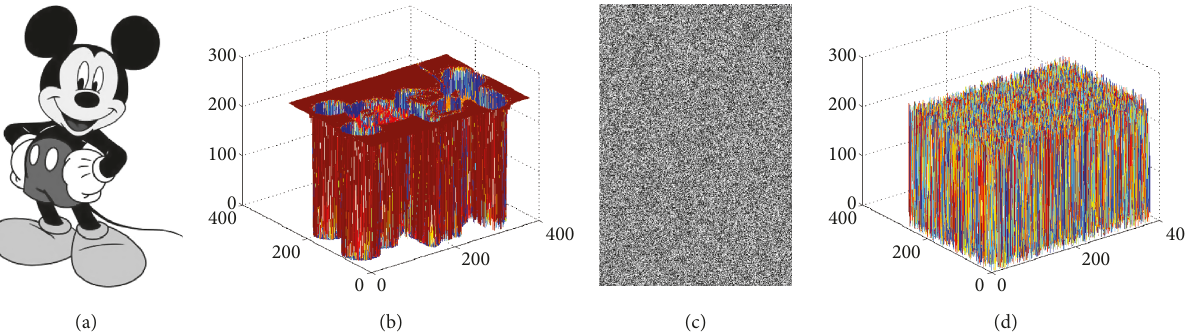
Figure 5: Histogram of triangle gray Mickey Mouse image and its encrypted image: (a) Mickey Mouse image; (b) histogram of (a); (c) encrypted image; (d) histogram of (c).